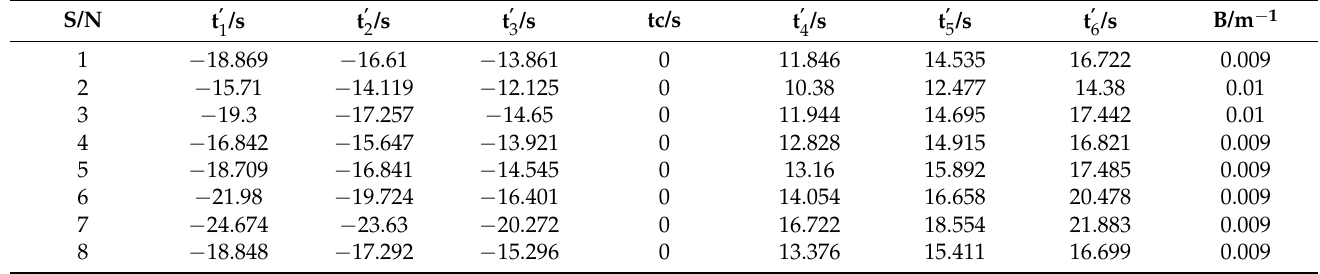
Table 3. Average values of B and the pulse-time calibration using our new model.